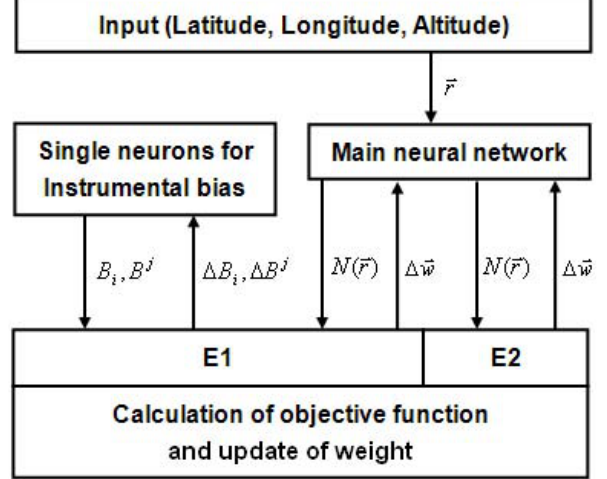
Fig. 1. Schematic diagram of the data flow for ionospheric tomog- raphy using RMTNN. In the figure, 1 w is the update value for the main neural network, and 1B i and 1B j are the instrumental bias of the i th ground receiver and the j -th satellite bias, respectively.